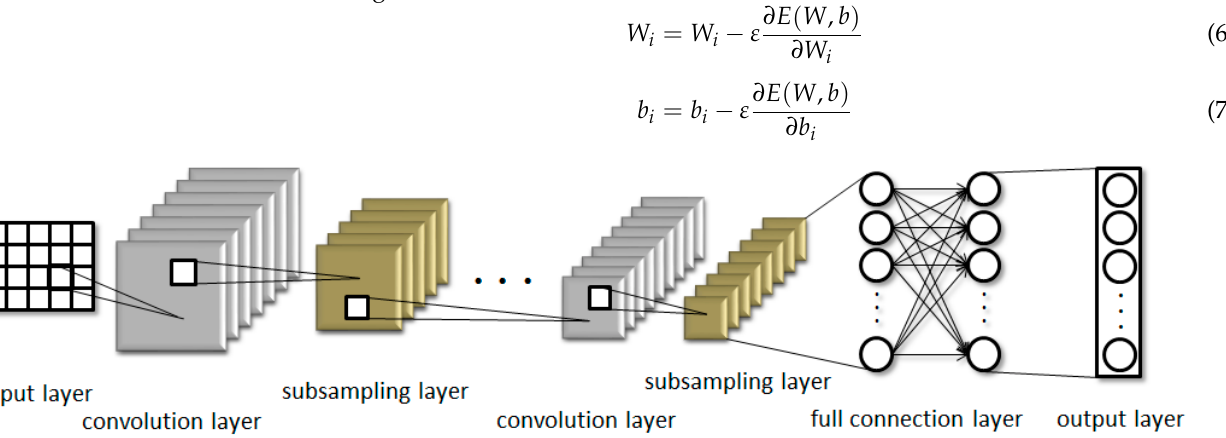
Figure 1. Schematic diagram of the structure of CNN.